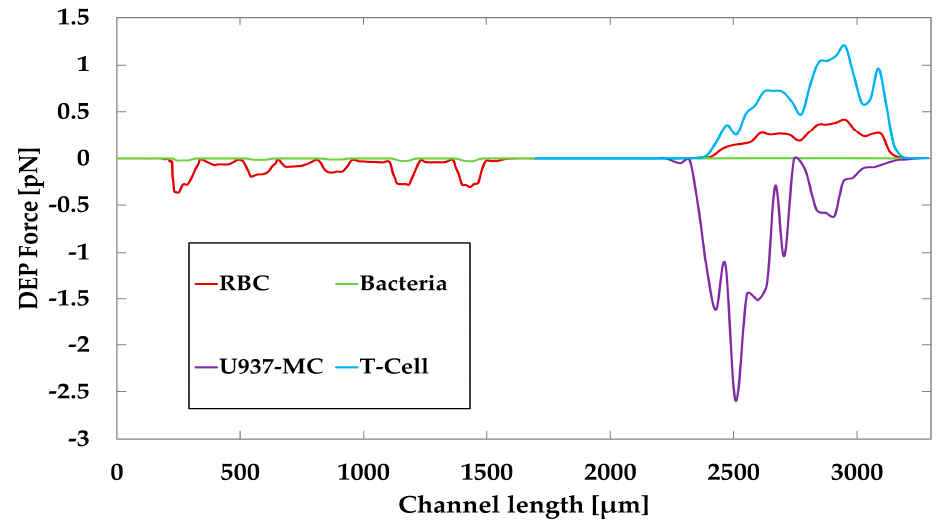
Figure 11. Applied doelectrophoresis (DEP) force on cells along the microchannel.